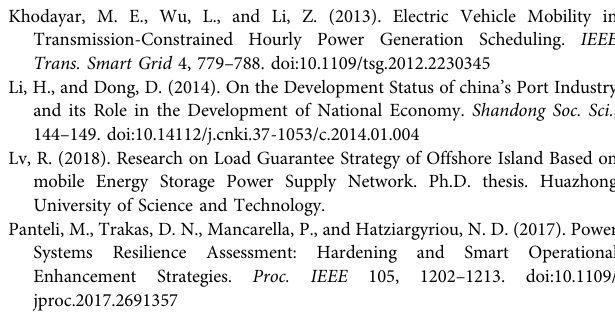
Figure 5 denotes the load recovery of joint post-disaster restoration scheme for AESs and generation scheduling in microgrids. The line diagram is identical as the load curve in Figure 3 , indicating the change of local load. The variation of the median value of the column chart are perfectly in tune with restoring load. Figure 6 shows the stacked generation dispatch for microgrids and AESs. The lower part of the bar represents the equivalent active power generated by the distributed emergency equipment; the opposite depicts the feeding of power from AES to the port, which describes the load distribution explicitly. Therefore, it can be observed that the active power within each port is balanced along the optimization horizon while AES participate in